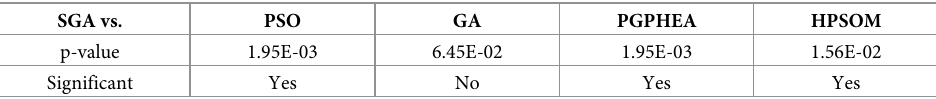
Table 13. Wilcoxon signed-rank-test ( p � 0.05) for average error in continuous problems. SGA